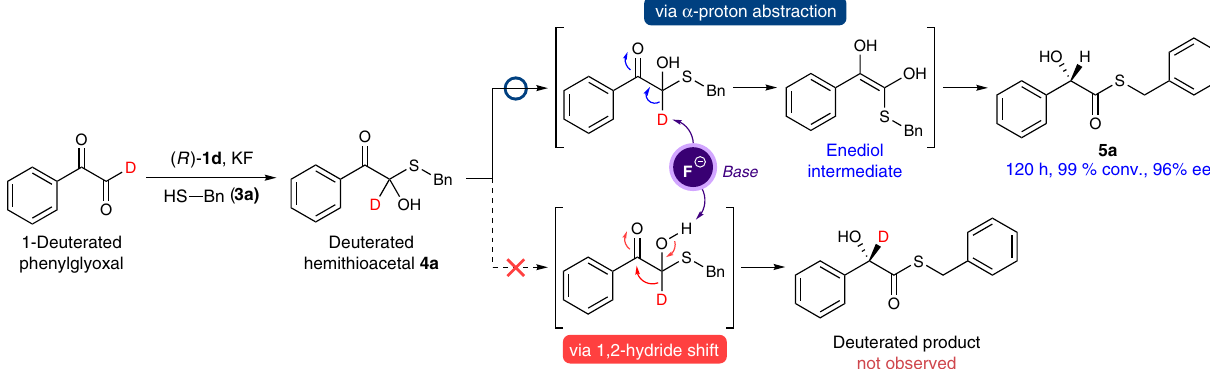
Figure 5 | Isotope experiment with [1- 2 H]-phenylglyoxal. The reaction was performed with [1- 2 H]-phenylglyoxal (0.1mmol), 3a (1.0 equiv.), ( R )- 1d (10mol%) and KF (2.0 equiv.) at 20 (cid:2) C.